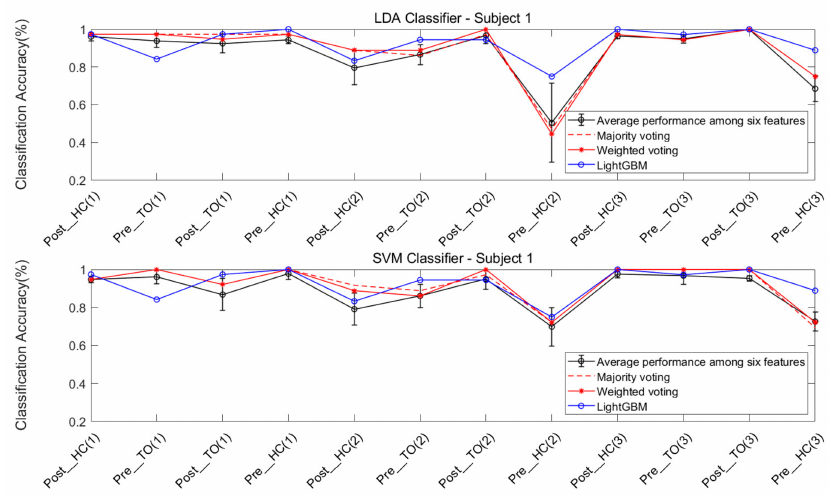
Figure 12. Classification performance for the ensemble learning method; Subject